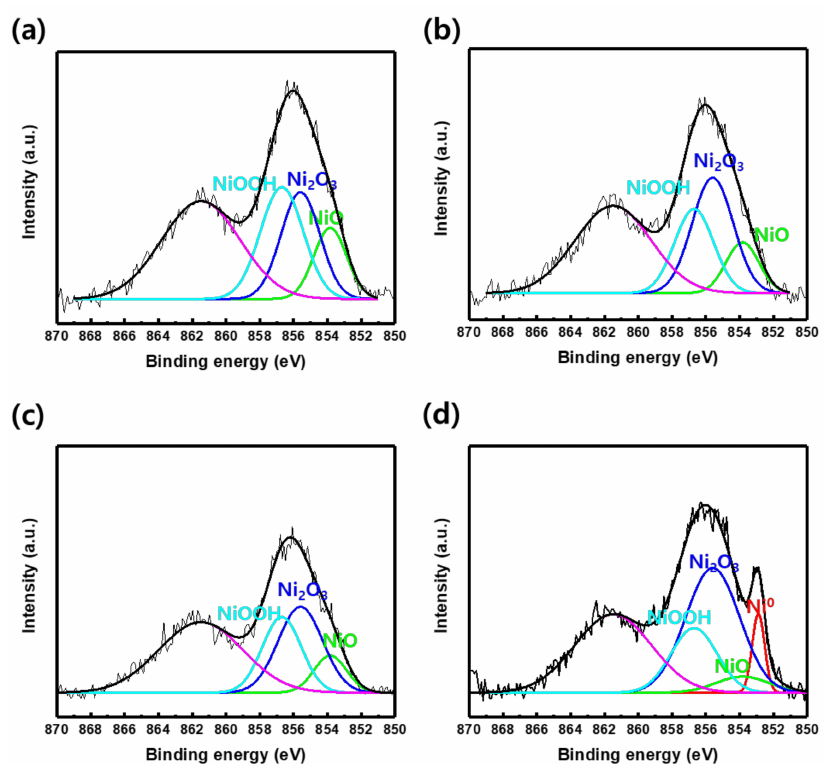
Figure 8. XPS spectrum of Ni 2p 3/2 according to: ( a ) as-deposited; ( b ) 300 ◦ C; ( c ) 400 ◦ C; ( d ) 500 ◦ C annealing temperature.